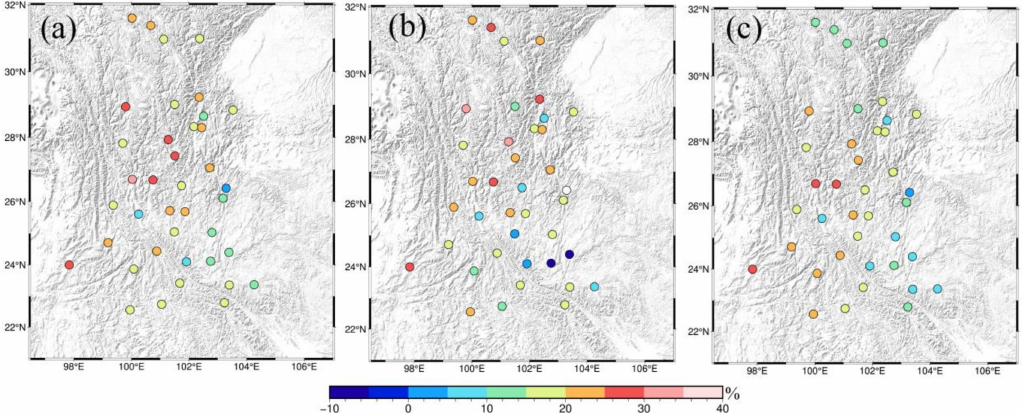
Figure 5. RMS reduction between GNSS vertical time series and HYDL time series provided by EOST ( a ), GFZ ( b ), and IMLS ( c ) for all stations in the Chuandian region.